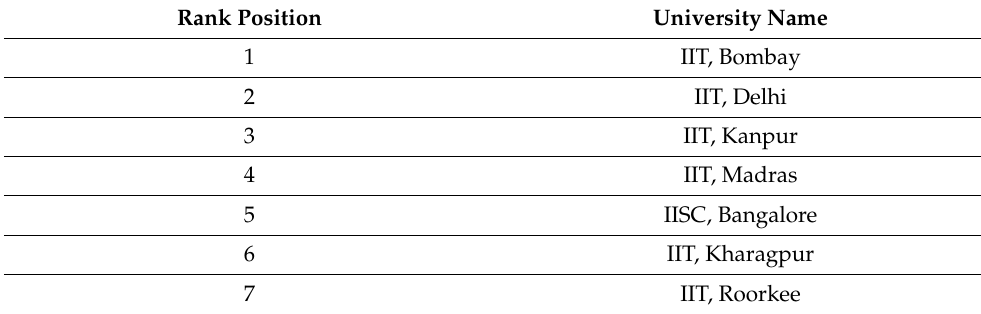
the ranking, which assigns a numerical value corresponding to the rank of the books. For details, please see [48].